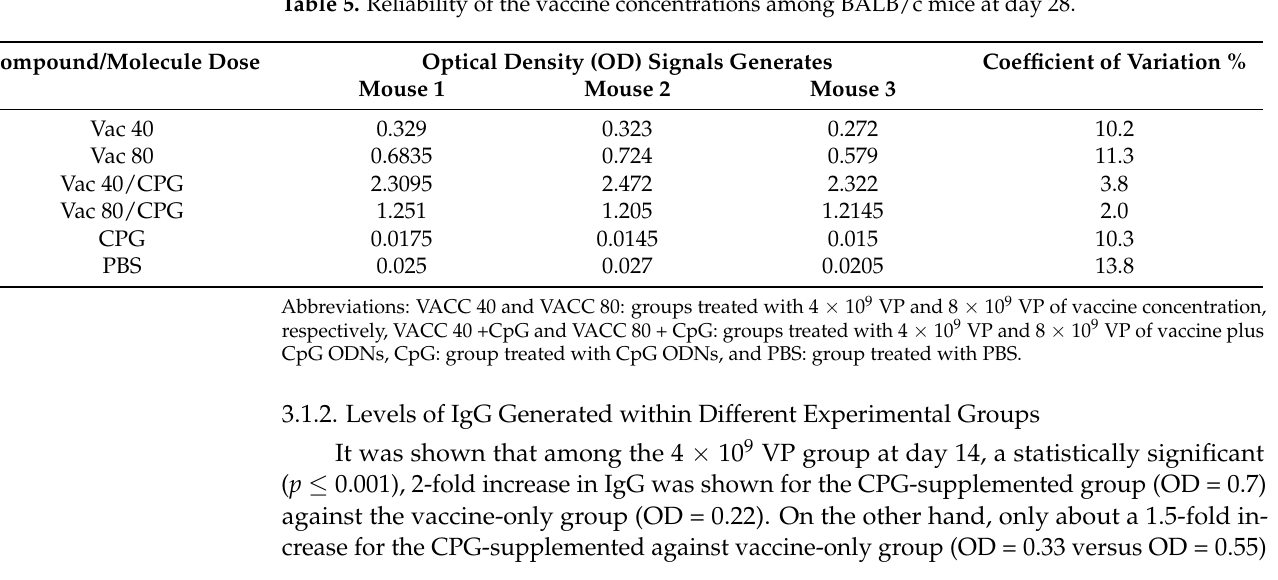
Table 5. Reliability of the vaccine concentrations among BALB/c mice at day